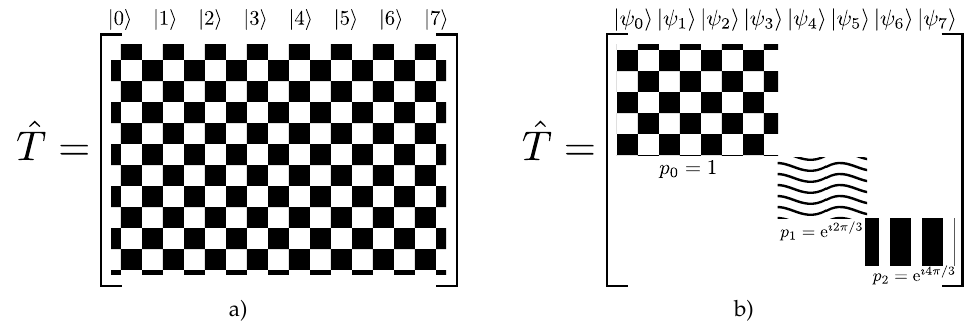
Figure 3. Reduction of the transition matrix to block diagonal form. ( a ) In the configurational vector space, {| µ (cid:105)} , the matrix representation of ˆ T lacks an explicit mathematical pattern. ( b ) The emergence of organizational patterns are observed whenever symmetries of ˆ T are correctly addressed by employing the eigenvectors { ψ } and eigenvalues { λ } corresponding to the symmetry group considered. Under the invariant basis { ψ } , the matrix representation of ˆ T is brought to a block diagonal form, with blocks labeled by eigenvalues { λ } .